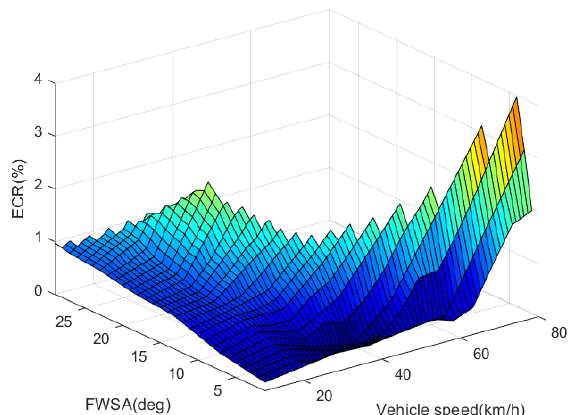
Figure 4. Energy-saving effect of optimal torque distribution.